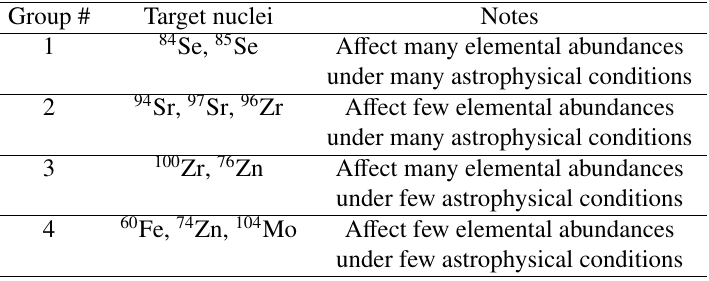
Table 1. Target nuclei whose ( α, xn ) reactions a ff ect the elemental abundances of 38 ≤ Z ≤